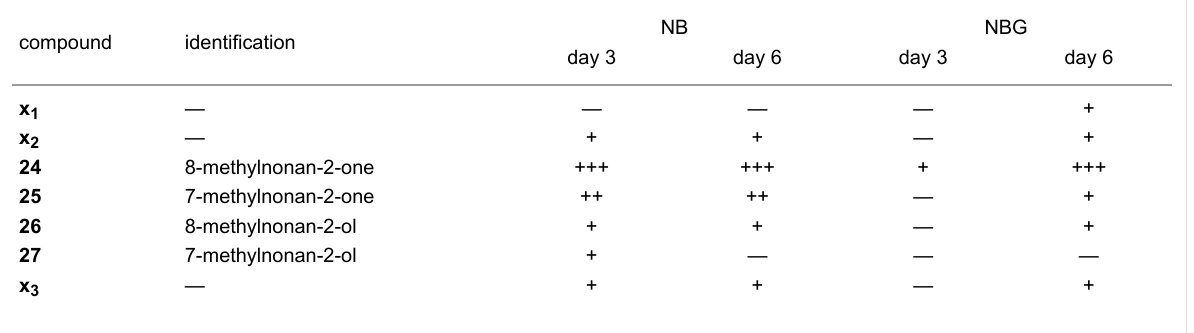
Table 2: GC/MS analysis of SPME trapped volatiles emitted from Xanthomonas campestris pv. vesicatoria 85-10 grown in a Petri dish on NB or NBG. a